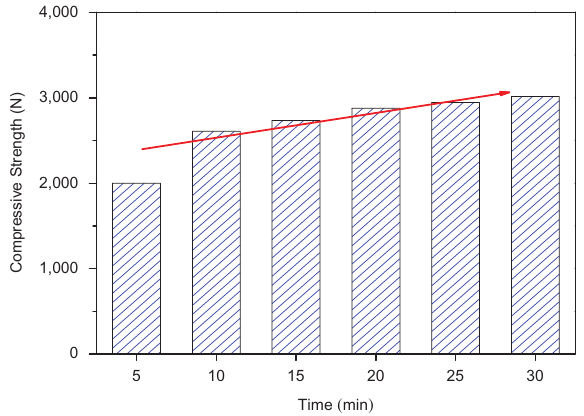
Figure 10: Effect of roasting time on the CS of HCVTM oxidized pellet (1,573 K).